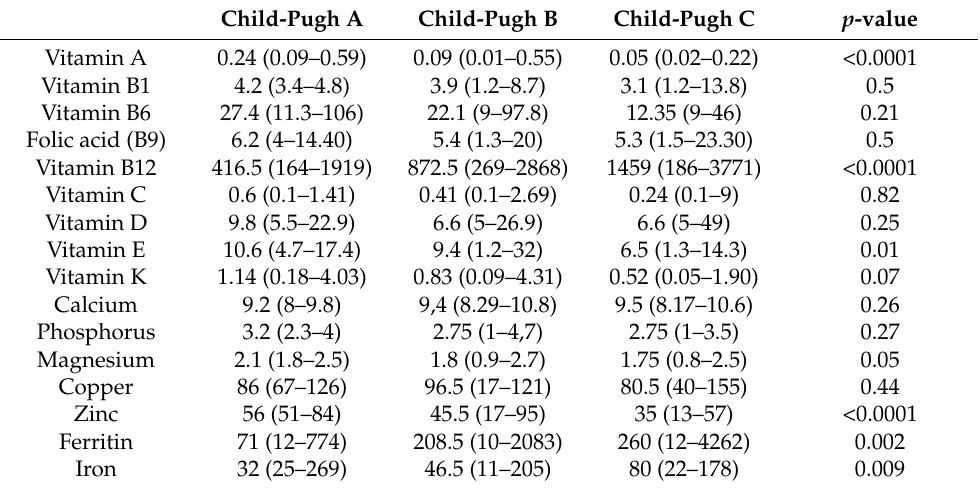
Figure 1. Bar chart of the serum levels of the micronutrients that reached statistical significance when analyzed depending on etiology of cirrhosis as a dichotomic variable. ( a ) Etiology of cirrhosis and vitamin A levels. ( b ) Etiology of cirrhosis and vitamin B12 levels. ( c ) Etiology of cirrhosis and zinc levels. ( d ) Etiology of cirrhosis and vitamin D levels. ( e ) Etiology of cirrhosis and vitamin E levels. ( f ) Etiology of cirrhosis and copper levels. Table 4. Serum concentrations of micronutrients according to Child-Pugh class. Univariate